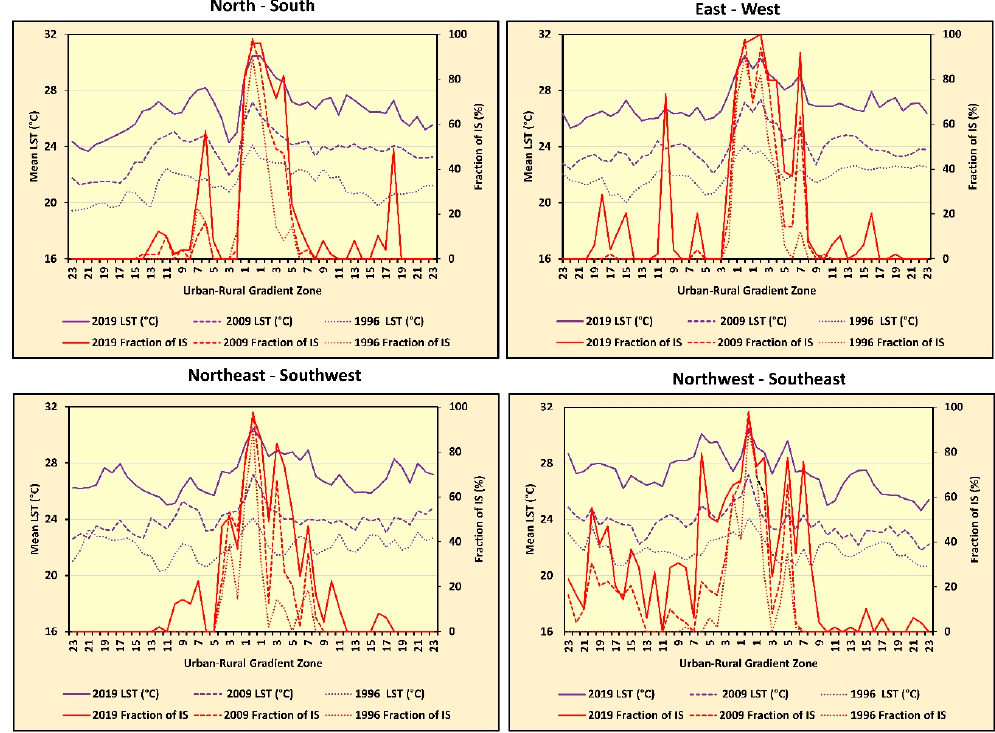
Figure 6. Multi-directional UHI profiles of KUA based on the mean LST and the FIS in 1996, 2009 and 2019.